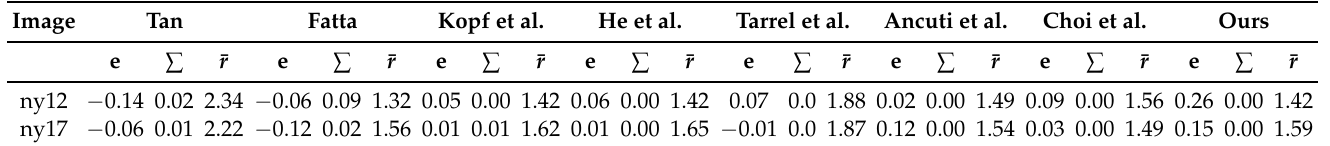
Table 1. Quantitative comparisons on the real-world images of “ny12” and “ny17” using e , ∑ and ¯ r in [31]. Image Tan Fatta Kopf et al. He et al. Tarrel et al. Ancuti et al. Choi et al.